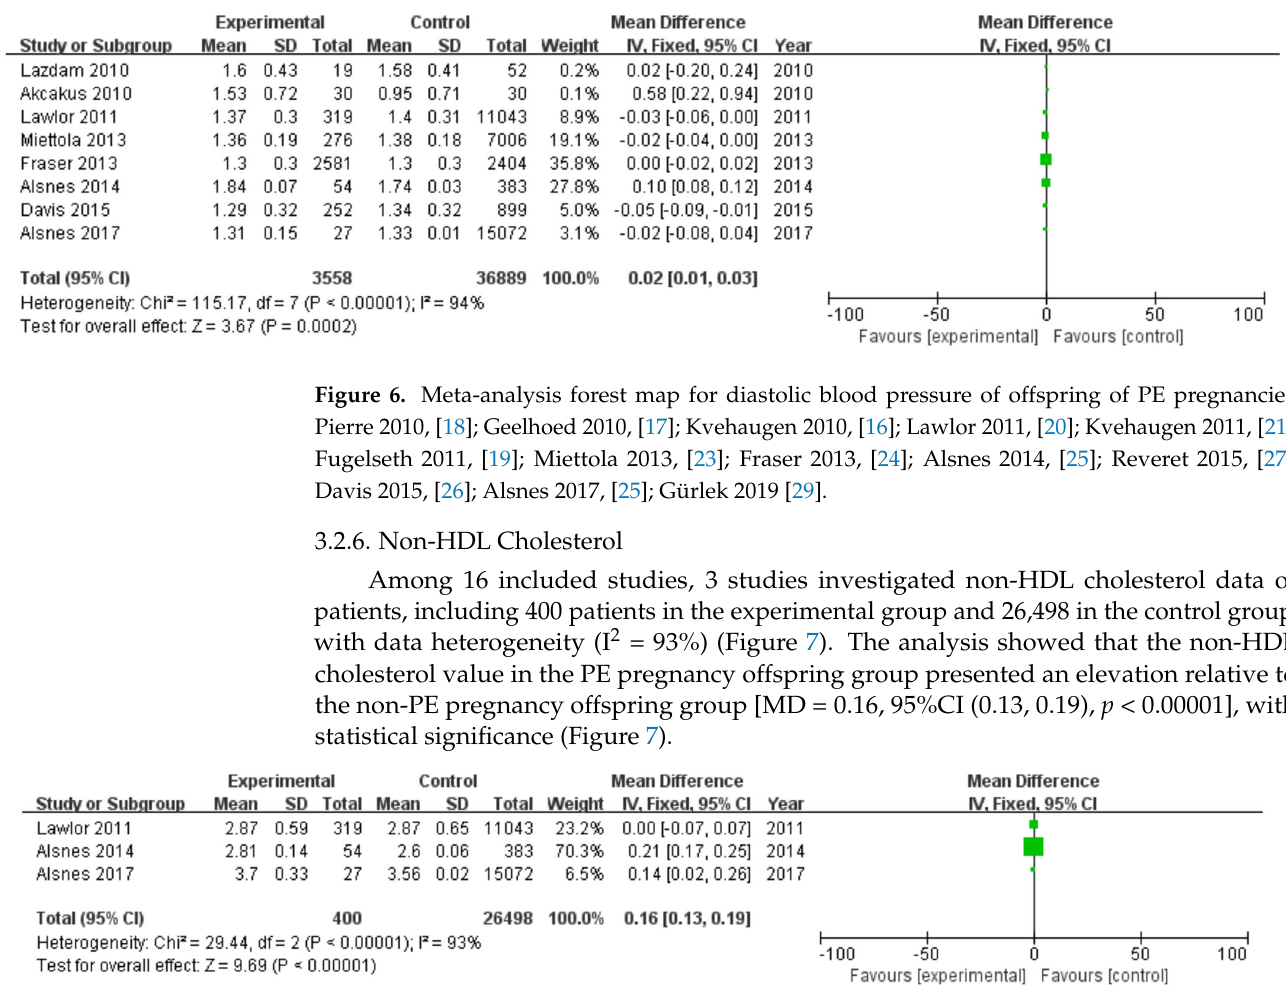
Figure 7. Meta-analysis forest map for non-HDL cholesterol of offspring of PE Figure 7. Meta ‐ analysis forest map for non ‐ HDL cholesterol of offspring of PE pregnancies. Law ‐